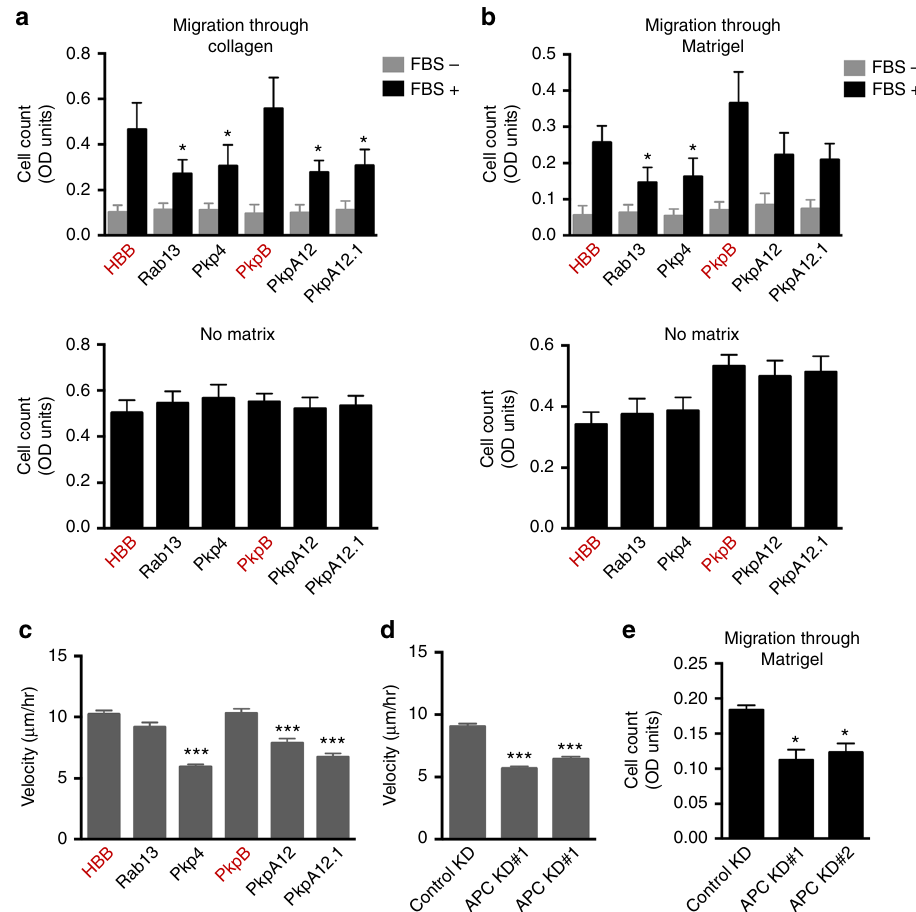
Fig. 8 Localization of APC-dependent RNAs is required for ef fi cient migration on 2D and 3D substrates. a , b Cell lines, stably expressing β -globin constructs with the indicated UTRs, were plated on top of collagen gel a or Matrigel b and were induced to migrate by addition of serum (FBS) in the bottom chamber. The amount of cells reaching the bottom was quanti fi ed from at least 5 independent experiments, (error bars: standard error). Lower panels show the amount of cells reaching the bottom in the absence of matrix, in parallel experiments, to control for cell viability during the assay. Note that because of the length of the assay, migration in the absence of matrix does not re fl ect migration speed. c , d Cells stably expressing constructs with the indicated UTRs c or transfected with the indicated siRNAs d , were monitored while randomly migrating. Average velocity values were derived from multiple individual cell tracks in two independent experiments observing 40 – 70 cells in each. e Migration through Matrigel of control or APC knockdown cells. p -values: *** < 0.0001, * < 0.05 against HBB or si-Control, by analysis of variance with Bonferroni ’ s multiple comparisons